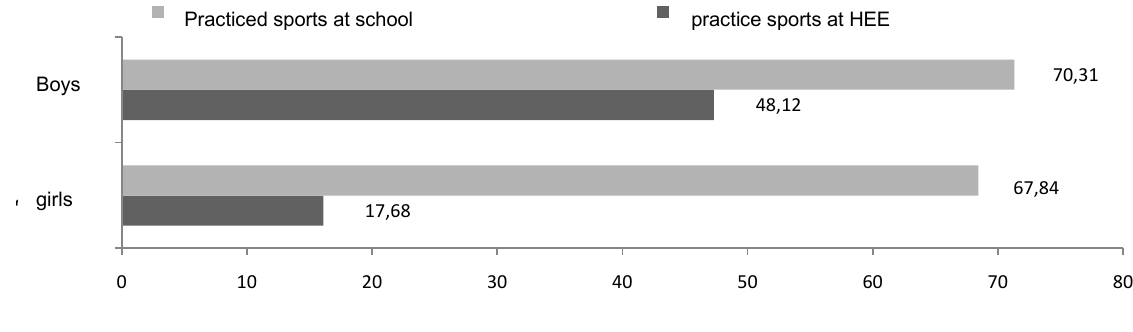
Fig.9. Attendance of sport circles by SRU “BelSU” students before entering HEE and at